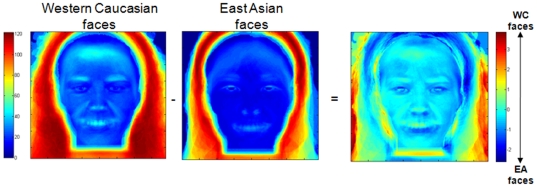
Standard deviation from the mean of the pixel values (gray level: 1-256) of the Western Caucasian (WC - left) and East Asian (EA - middle) faces used in the experiment.
Right: Pixel information biases for WC (red) and EA (blue) faces. Note the absence of any significant differences in the pixel space across faces for faces from different culture (Zcrit>|4.25|, P<.05), indicating the absence of evident diagnostic information for observers.